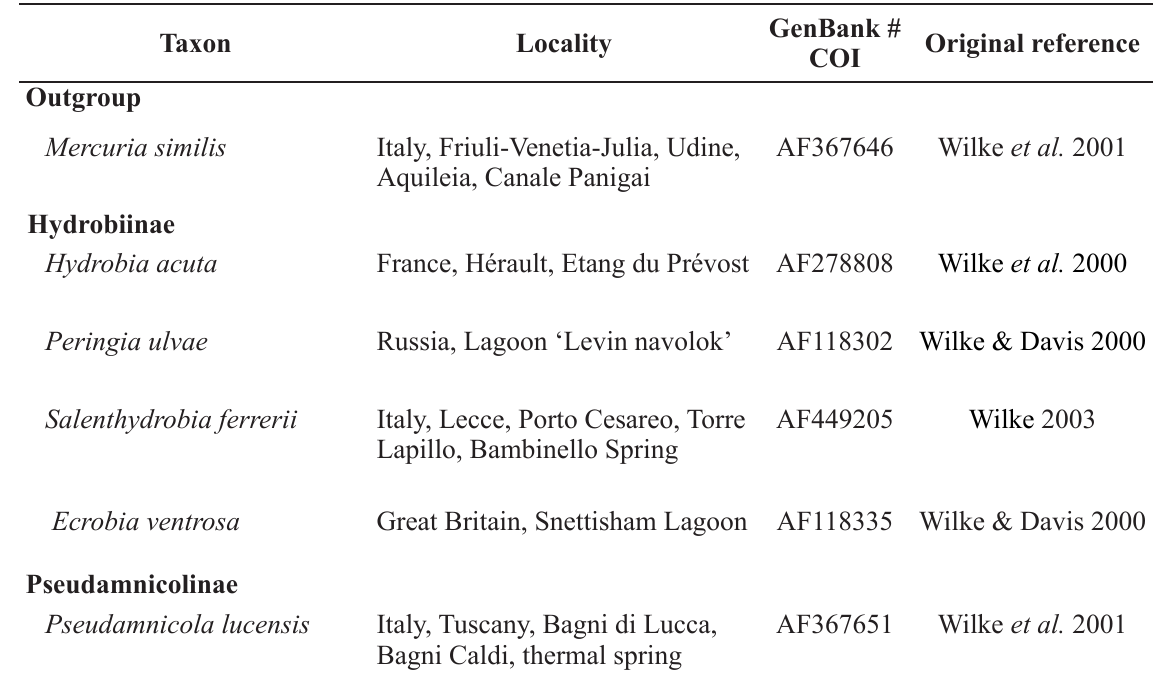
Table 1. Locality name, GenBank accession numbers and original references for the species employed in the molecular